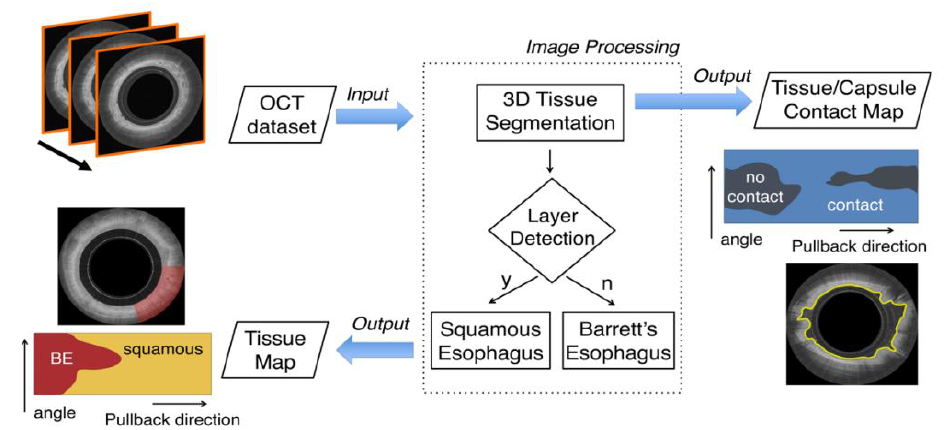
Figure 14. Flowchart of the entire automated processing framework. The algorithm receives as its input an entire OCT pullback data set that typically comprises > 1000 images. Initially, the algorithm automatically locates the position of the tissue’s surface over the entire 3D data set and then tissue characteristics are assigned. Squamous esophagus is differentiated from BE (with or without dysplasia) tissue by identifying the presence of horizontal layers. The output of the algorithm is a tissue map of the entire data set, automatically depicting the presence of BE and a contact map showing areas that lack contact between the capsule and the tissue. [192].